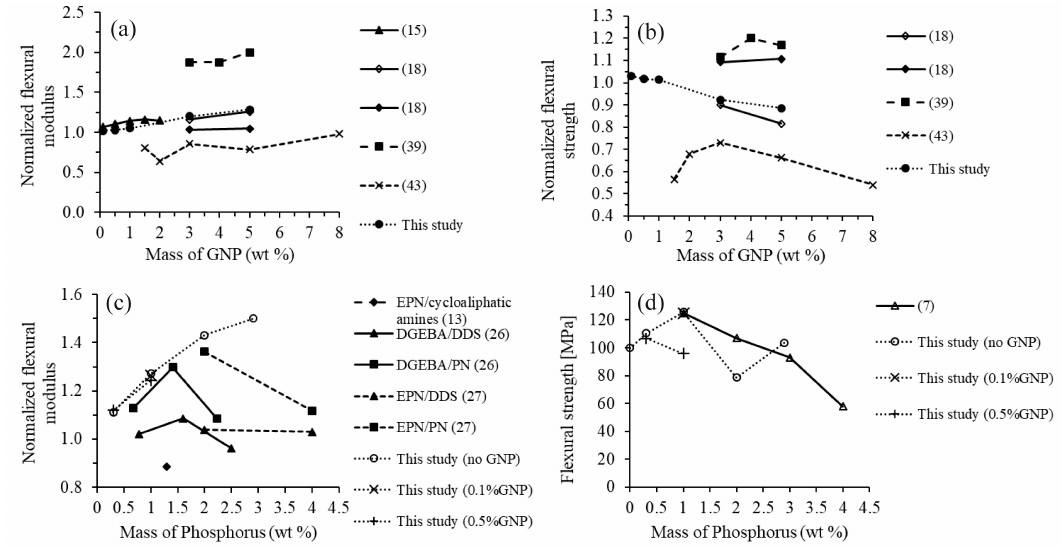
Figure 6. Comparison among different studies of the effect of GNP on the ( a ) flexural modulus and ( b ) flexural strength of epoxy nanocomposites normalized to neat epoxy resin and the effect of DOPO on the ( c ) flexural modulus normalized to neat epoxy resin and ( d ) flexural strength in MPa